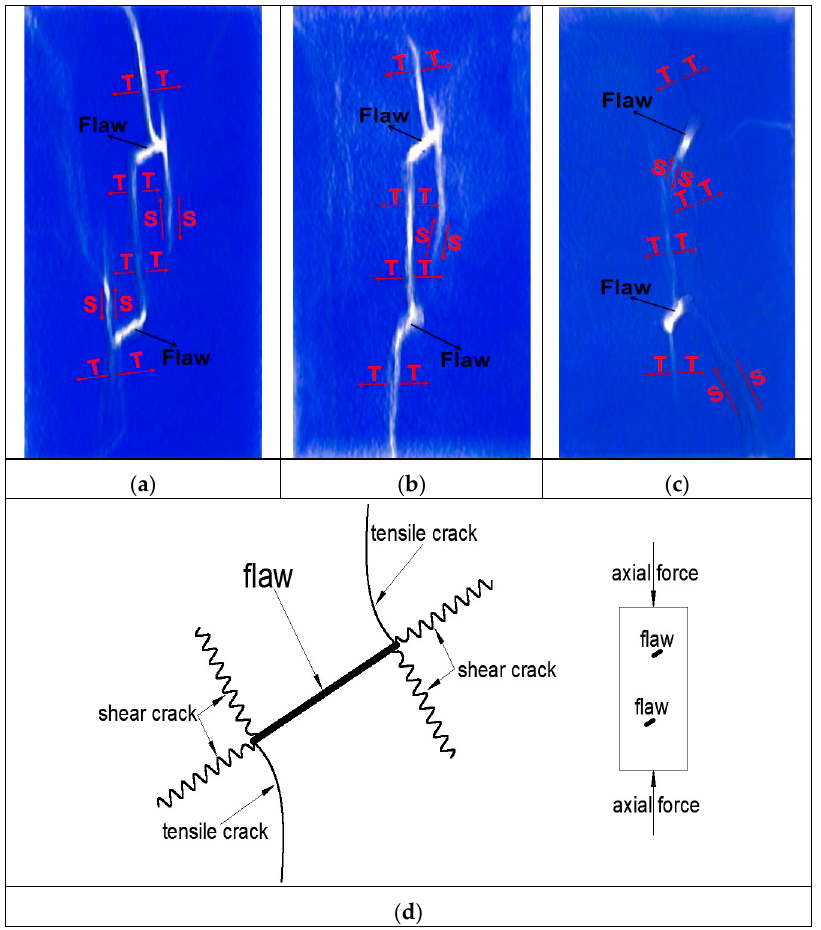
Figure 5. The final crack patterns of specimens containing en echelon flaws: ( a ) B-30; ( b ) B-45; ( c ) B-60. ( d ) Simplified crack pattern observed in rock in uniaxial compression [4].